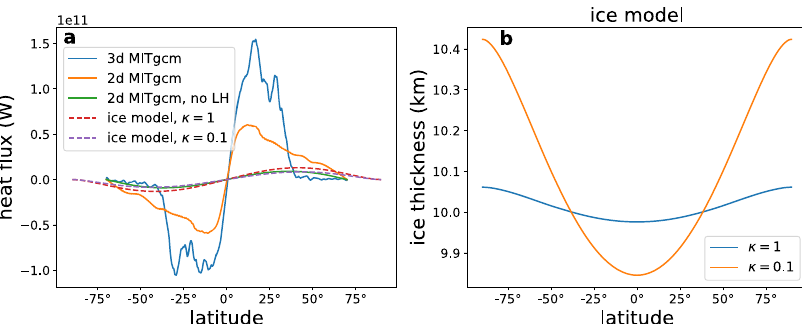
Fig. 6 Meridional ocean heat transport and implications for ice thickness. a The oceanic meridional heat transport calculated using the 2d and 3d ocean simulations in this work (solid lines). The heat transport is positive northward, so that the heat transport is poleward in both hemispheres. The green solid line shows the meridional transport calculated from the difference between the geothermal heat fl ux and the diffusive heat fl ux through the ice (text). Also shown (thin dash lines) are estimates of ocean heat transport using the slab ocean model of ref. 31 , coupled to an ice fl ow model, for two oceanic eddy mixing values, κ = 1, 0.1 m 2 s − 1 . b Ice thickness (km) associated with the heat transport curves shown in a (dashed lines) showing almost uniform ice thickness even for relatively small eddy mixing coef fi cient of κ = 1 m 2 s − 1